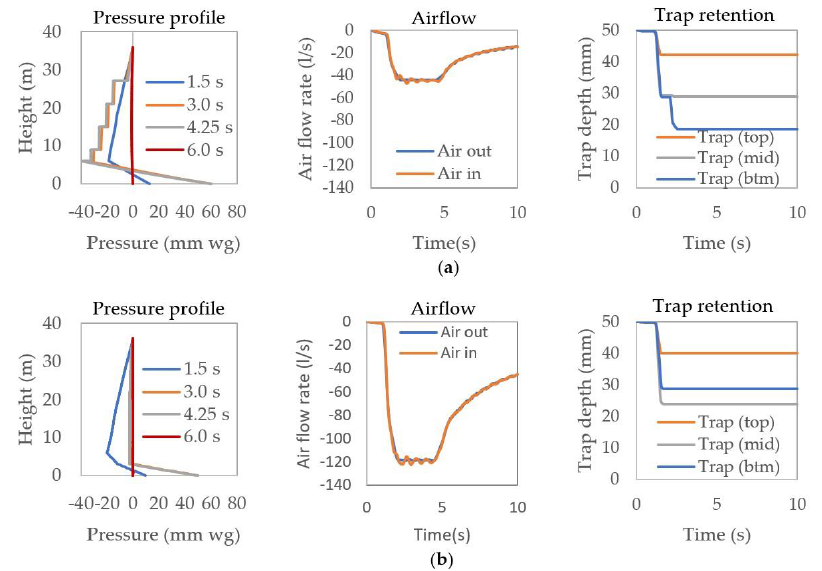
Figure 9. Simulated elements of operational performance, including the stack pressure profile, airflow, and resultant trap retention depth for the 10 story building as a single-stack system with ( a ) 100 mm diameter stack and ( b ) 150 mm diameter stack.